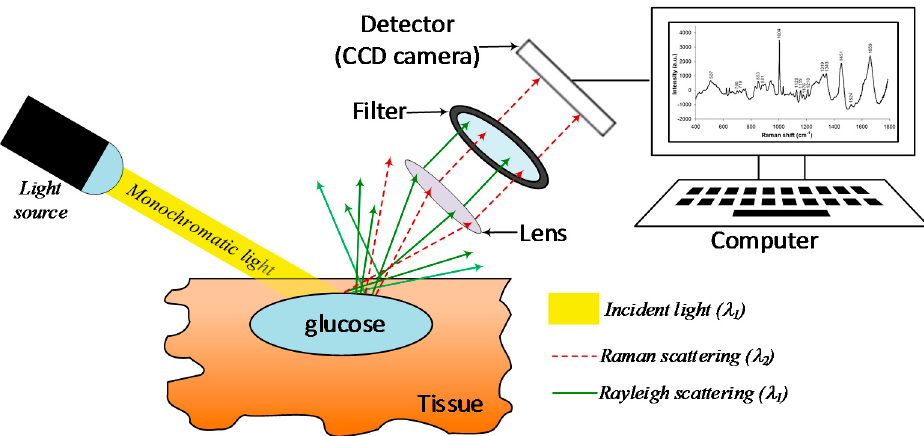
Figure 10. Schematic representation of a basic Raman spectroscopy instrument. Table 11. Advantages and disadvantages of Raman spectroscopy. Raman Spectroscopy